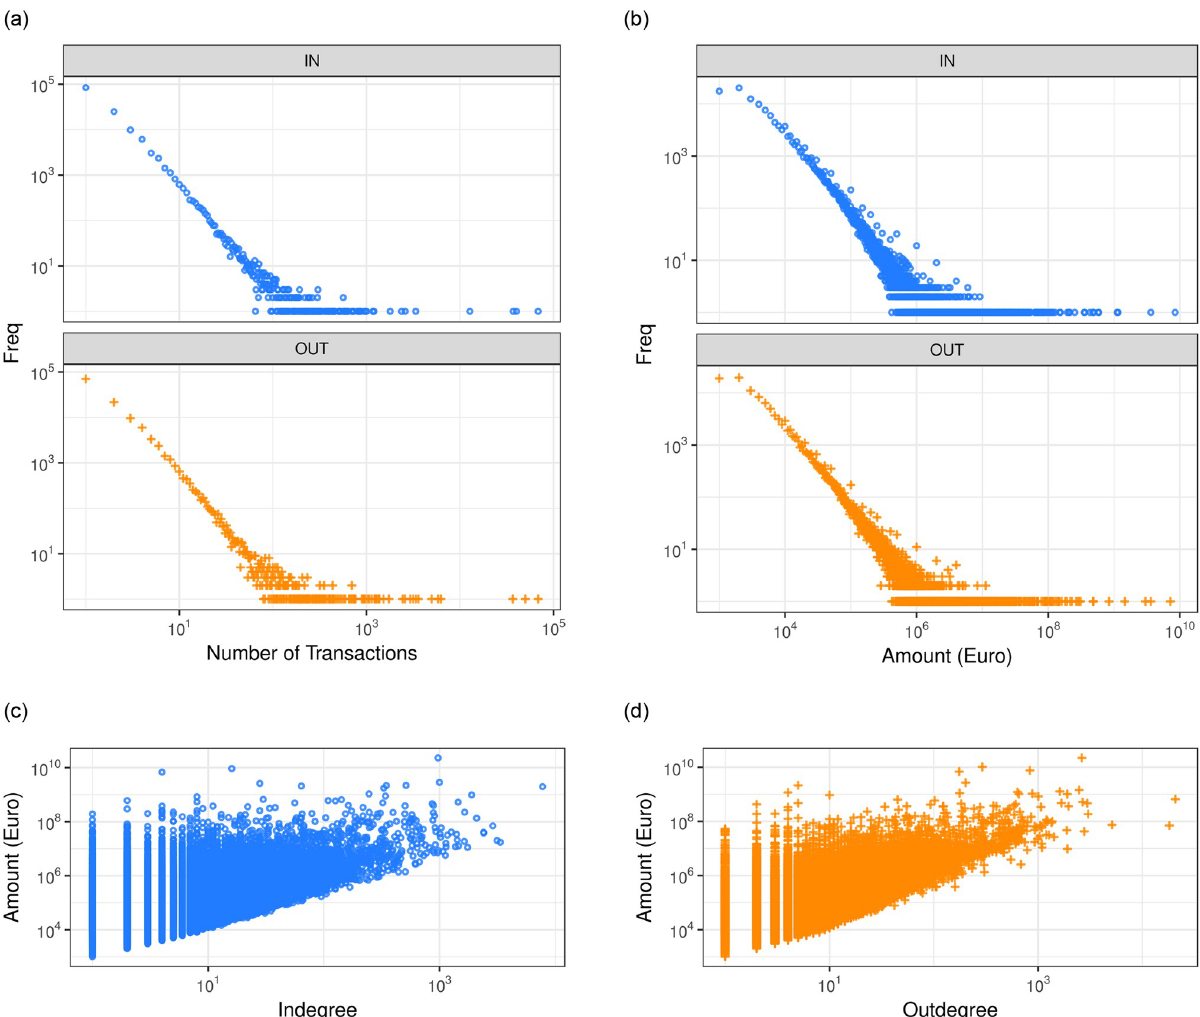
Fig 3. Distribution of (a) the number and (b) the amount of transactions. (c-d) Scaling relations between amount of transactions and degrees in log-log